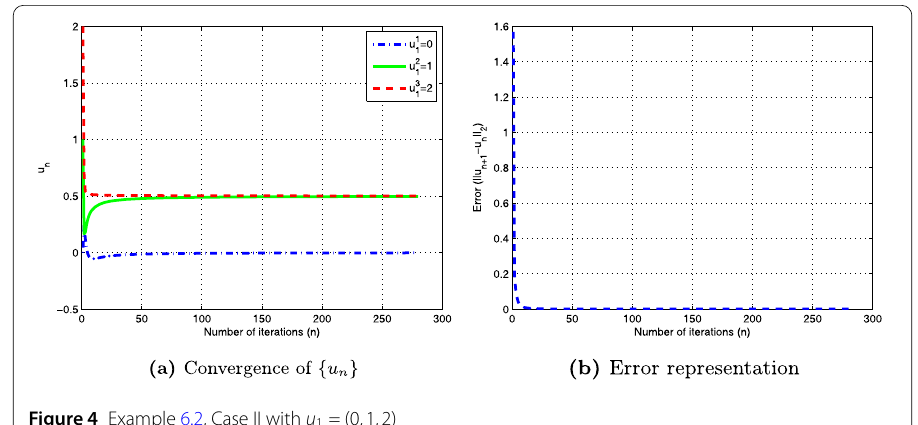
Figure 4 Example 6.2, Case II with u 1 =